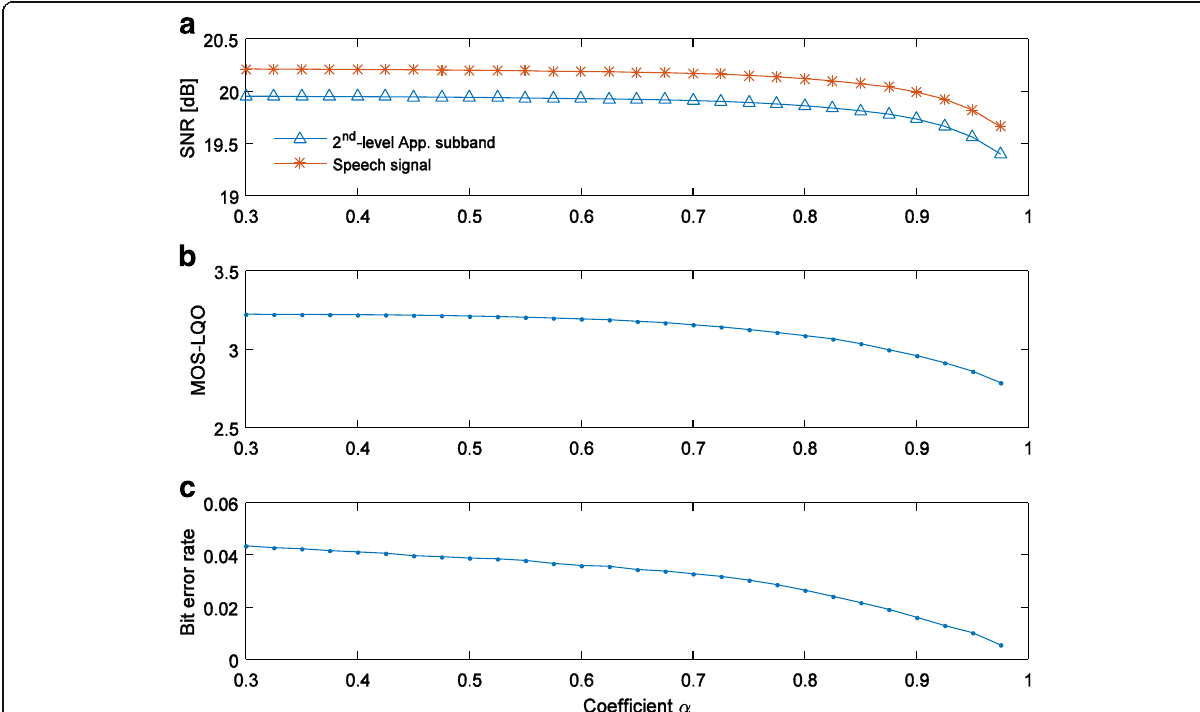
Fig. 6 The effect due to the use of various α s. Subplot a presents the SNRs observed in the second-level approximation subband and time-domain signal. Subplot b delineates the MOS-LQO scores. Subplot c is the result when the watermarked speech is corrupted by white Gaussian noise with